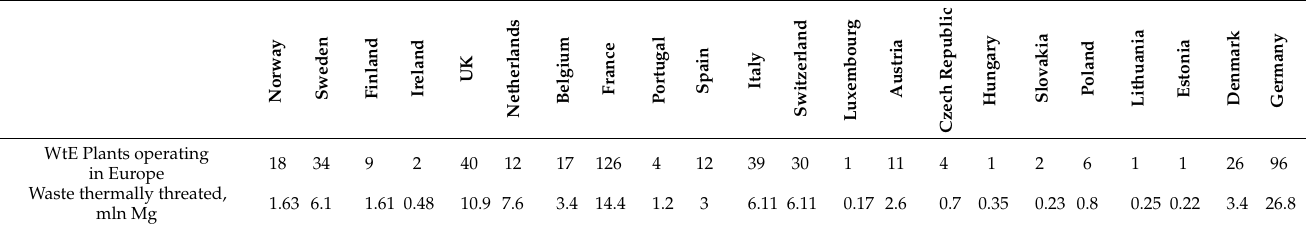
Table 2. Number of WtE plants operating in Europe (not including hazardous waste incineration plants) and waste thermally treated, mln Mg w 2017.